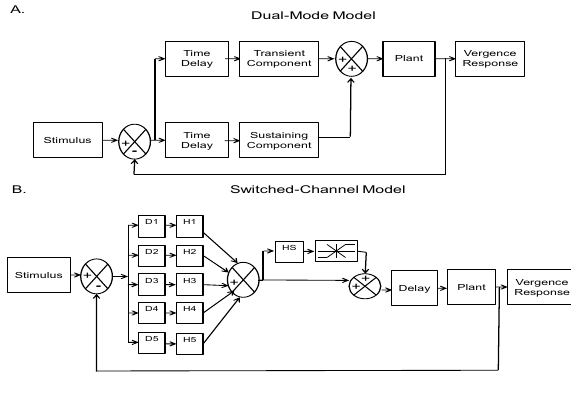
Figure 1: Block diagram of the (A) Dual-mode model and (B) Switched-channel